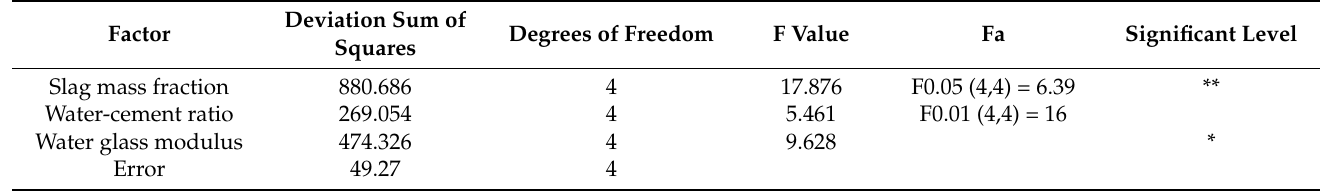
Table 8. Variance analysis table of 7 − day compressive strength results of orthogonal test. Table 9. Variance analysis table of 28-day compressive strength results of orthogonal